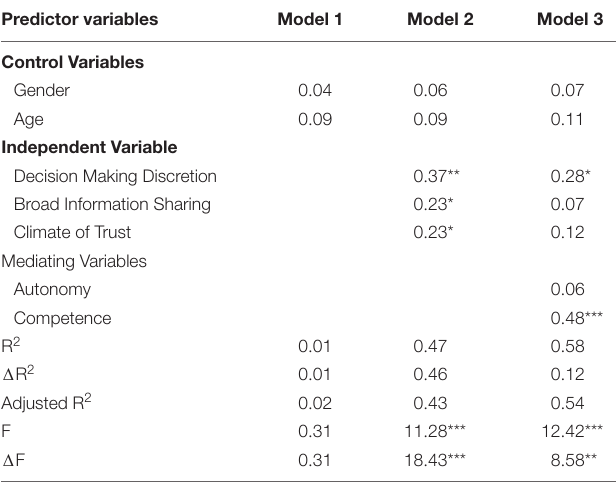
TABLE 4 | Hierarchical regression for